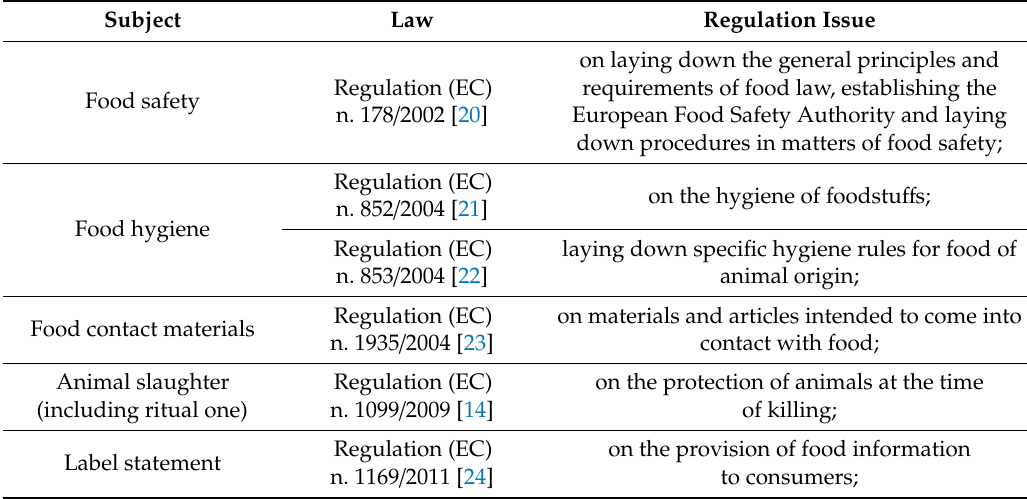
Table 1. Rules providing the regulation of h.al¯al foods in